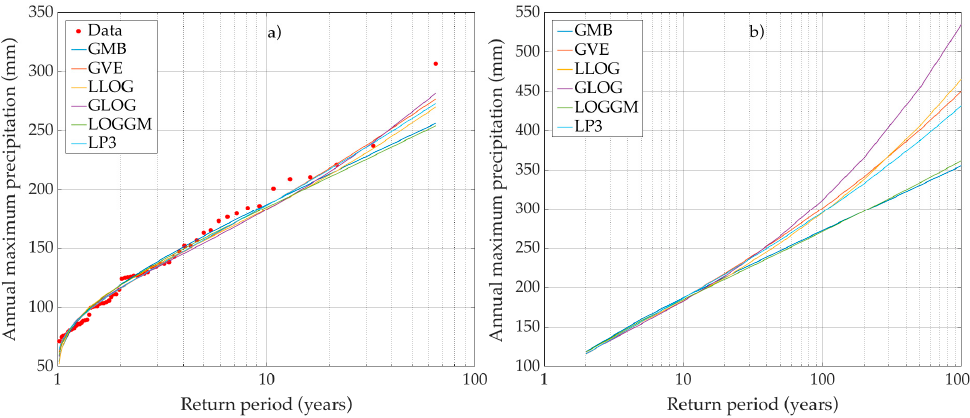
Figure 6. Frequency analysis of maximum yearly precipitation recorded at the station 27037: ( a ) fitted distributions; and ( b ) estimated quantiles.